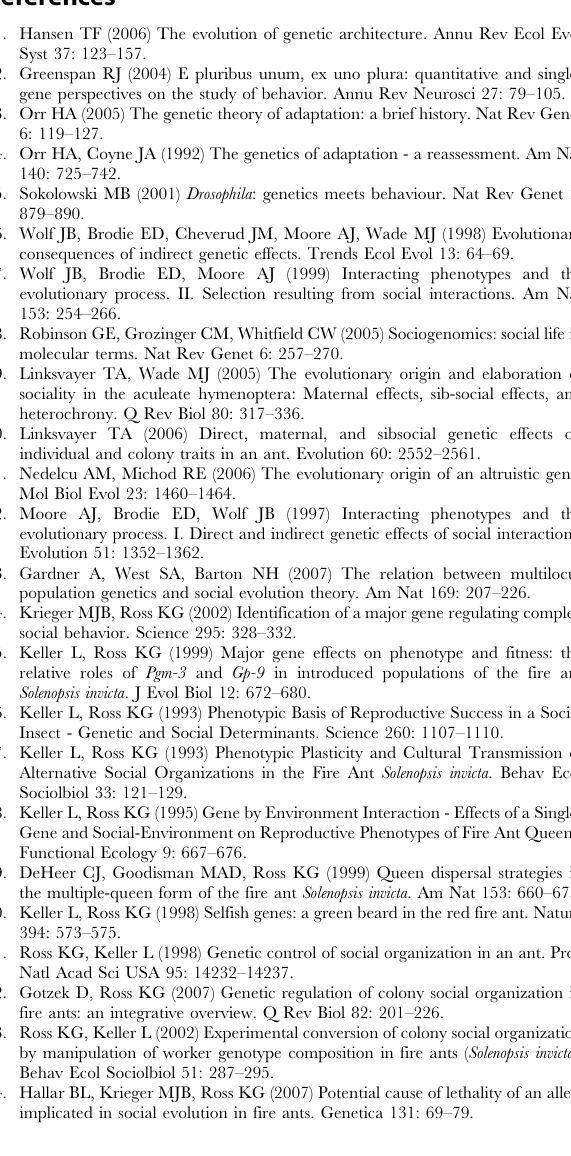
Table S5 Genes, primer sequences, and primer concentrations used for qRT-PCR verification of microarray expression data. Found at: doi:10.1371/journal.pgen.1000127.s006 (0.02 MB